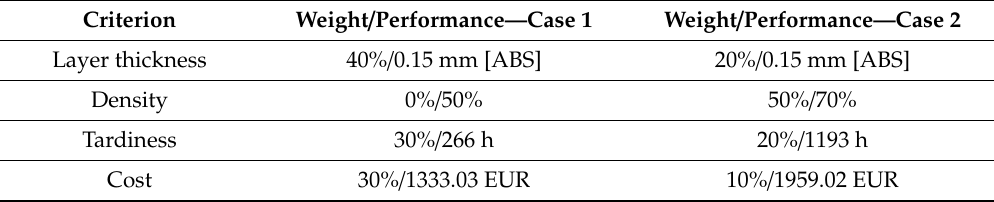
Table 1. Comparison of test cases results.